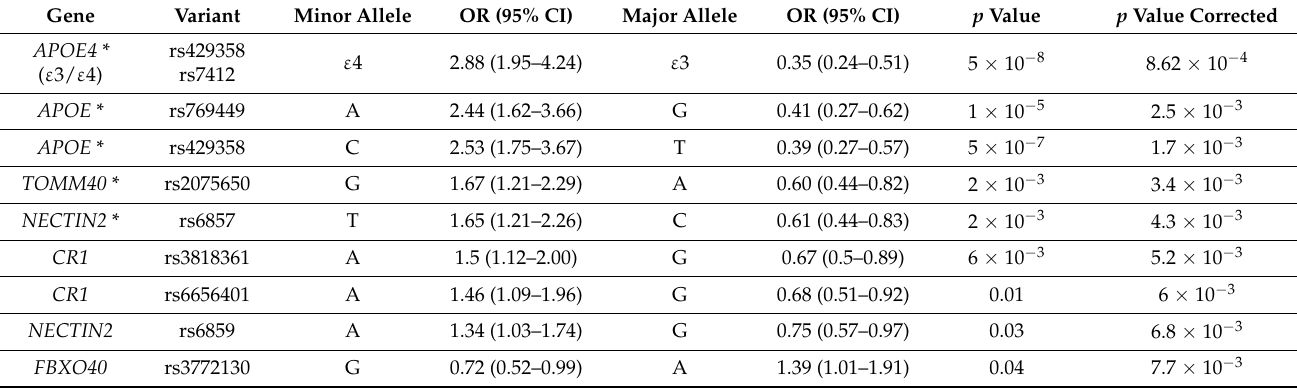
Table 3. Association of statistically significant genetic markers with LOAD in the Russian